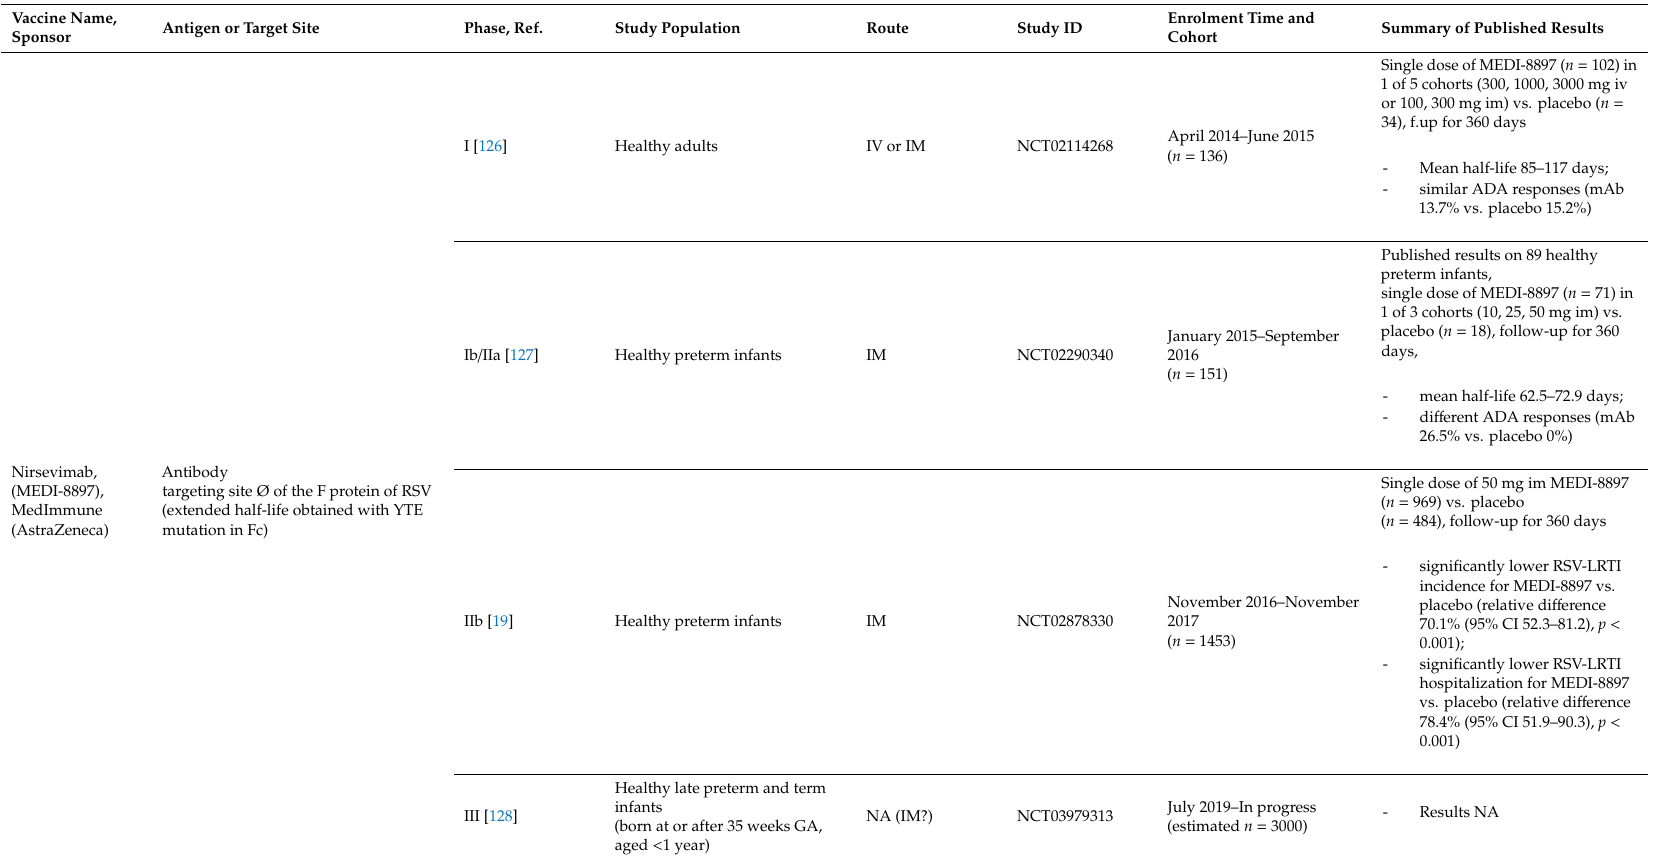
Table 6. Overview of the anti-RSV monoclonal antibodies in clinical development. Ab: antibody; ADA: anti-drug antibody; AE: adverse event; Ag: antigen; CI: confidence interval; CHD: congenital heart defect, CLD: chronic lung disease; COPD: chronic obstructive pulmonary disease; Corp: corporation; f.up: follow-up; GA: gestational age; IM: intramuscular; IN: intranasal; IV: intravenous; LRTD: lower respiratory tract disease; LRTI: lower respiratory tract infection; mAb: monoclonal antibody; NA: not available; NIAID: National Institute of Allergy and Infectious Diseases; PCA: palivizumab-competing antibody; PIV3: Parainfluenza Virus type 3; Ref: reference; RSV: respiratory syncytial virus; RT-PCR: reverse transcriptase polymerase chain reaction; SAE: serious adverse event; TCID 50 : Tissue Culture Infectious Dose 50%; vs.: